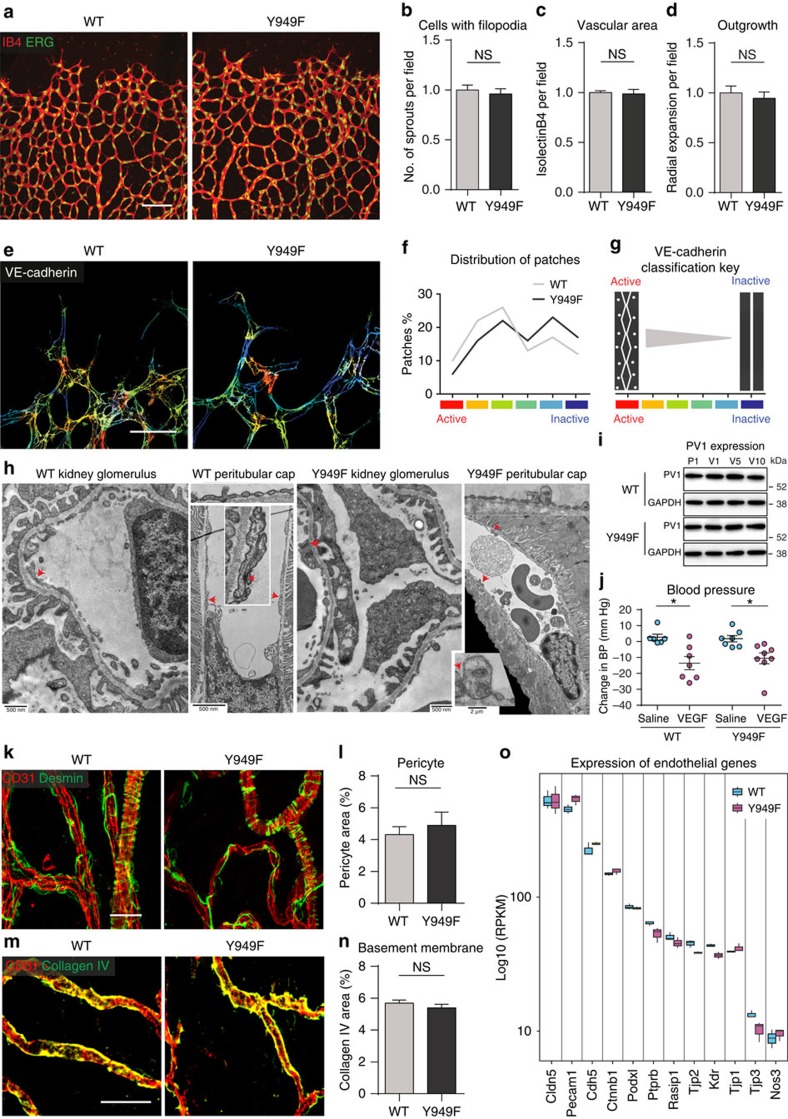
Vegfr2Y949F/Y949F vessel parameters.(a) Isolectin-B4 (IB4, red) and ERG (green) immunostaining on WT and Vegfr2Y949F/Y949F (Y949F) P6 retinal vasculature. Scale bar, 100 μm. (b) Tip cells numbers. n=3–4 retinas per genotype. (c) IB4-positive vessel area normalized to WT. n=3–4 retinas per genotype. (d) Radial vessel outgrowth normalized to WT. n=4–5 retinas per genotype. (e) Heatmap of VE-cadherin morphology in WT and Vegfr2Y949F/Y949F (Y949F) P6 retinas. Scale bar, 50 μm. (f) Retinal images in e processed for VE-cadherin morphology, lying within the vascular mask, into ‘patches' of 100 × 100 pixels (× 63, n=6 per group). The VE-cadherin morphology in each patch was hand-classified according to the classification key in g. (g) Adherens junctions classification from ‘active' (red; irregular/serrated morphology with diffuse/vesicular regions) to ‘inactive' (blue; straighter morphology with less vesicular staining). (h) Transmission electron microscopy analysis of kidney glomerulus and peritubular capillary (cap) show normal appearance of junctions (red arrows) and fenestrae (insets) in the two genotypes. (i) PV1 protein immunoblot in lung lysates after injection of PBS (P) or VEGFA (V) and circulation for 1–10 min (P1; injection of PBS and 1 min circulation and so on). GAPDH; equal loading. Molecular weight markers to the right. (j). Blood pressure 10 min after saline or VEGFA infusion, monitored in the ascending aorta. Values (positive or negative) show diastolic blood pressure (BP) normalized to BP before VEGFA/PBS injection (70 mm Hg; NS between genotypes). n=6–8 mice per genotype. Student's t-test, *P<0.05. Two-way ANOVA: P(treatment)=0.0001; P(genotype)=0.738; P(interaction)=0.5321. (k) CD31-positive (red) tracheal endothelium and desmin-positive (green) pericytes. Scale bar; 50 μm. (l) Pericyte area per total area from k. n=4 mice per genotype. (m) CD31-positive (red) tracheal endothelium and collagen IV-positive (green) basement membrane. Scale bar; 50 μm. (n) Collagen IV area per total area in m. n=3 mice per genotype. (o) RNAseq analysis of total lung polyA+ RNA. Data for selected endothelial genes as log10-scaled fold-change based on the frequency of normalized expression. For Vegfr2 (KDR) the Y949F mutant showed a −0.24 (DESeq2log2) fold decrease compared with WT. Data presented as mean±s.e.m. Student's t-test (b–d) and Wilcoxon rank test (f); NS, not significant. Experiments were performed three independent times or performed once with at least three independent data sets (j,o).